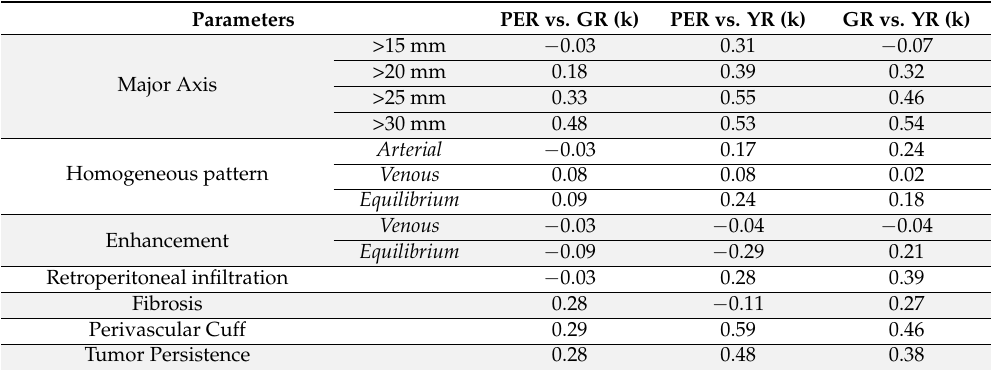
Table 5. IOA (Cohens’ k coefficient) among the three radiologists in the evaluation of single imaging parameters. IOA = Interobserver Agreement. PER = Pancreatic Expert Radiologist. GR = Middle-expert General Radiologist. YR = Young